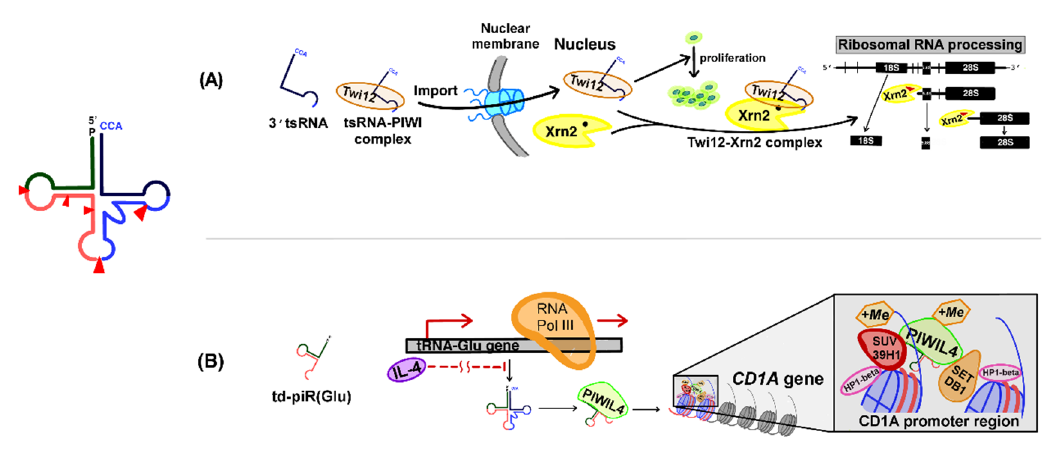
Figure 2. PIWI-dependent epigenetic regulation and function of tRNA-derived small RNAs: ( A ) Regulation of RNA processing in the nucleus. The Twi12-3 ′ tsRNA complex plays a role in cell proliferation. It also plays a role in the stabilization and nucleolar localization of Xrn2, a 5 ′ monophosphate-dependent nuclear exonuclease that is required for ribosomal RNA processing in the nucleus. ( B ) Histone modification in immune cells. IL-4 affects tRNA(Glu) expression; consequently, it inhibits the expression of the tRNA(Glu)-derived piRNA (td-piR(Glu)) precursor. td-piR(Glu) associates with PIWIL4 and recruits H3K9 methyltransferases (SETDB1 and SUV39H1) and heterochromatin protein 1 β (HP1 β ) to the CD1A promoter region, thereby facilitating H3K9 methylation. Hence, the transcription of CD1A is inhibited.